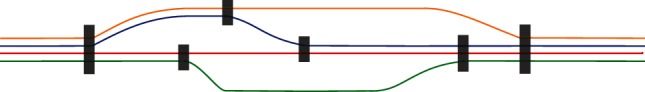
Sketch of a coloured de Bruijn graph with four alleles, each represented by a different colour. The branching nodes are marked in grey, and paths between those nodes correspond to contigs. All nodes of the same contig have the same set of colours.